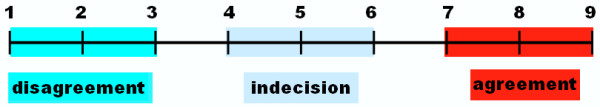
Process for determination of strong versus weak agreement. Each expert rated the recommendations on a scale from 1 to 9. A median score ± confidence interval was then calculated based on all expert votes (if necessary, one isolated higher or lower value was excluded). A median score between 1 and 3 indicated disagreement; a median score between 4 and 6 indicated indecision; a median score between 7 and 9 agreement. If the confidence interval was within or without the previous defined zones, the strength of agreement (or disagreement) was considered to be strong or weak, respectively.